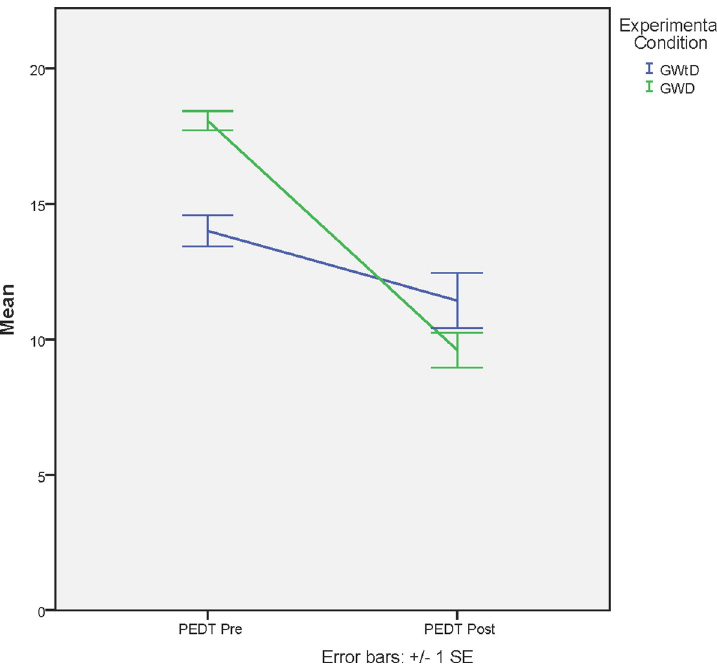
Fig 3. Pre-post PEDT between groups. Means in PEDT between GWD and GWtD. � Significant differences with p < 0.025.